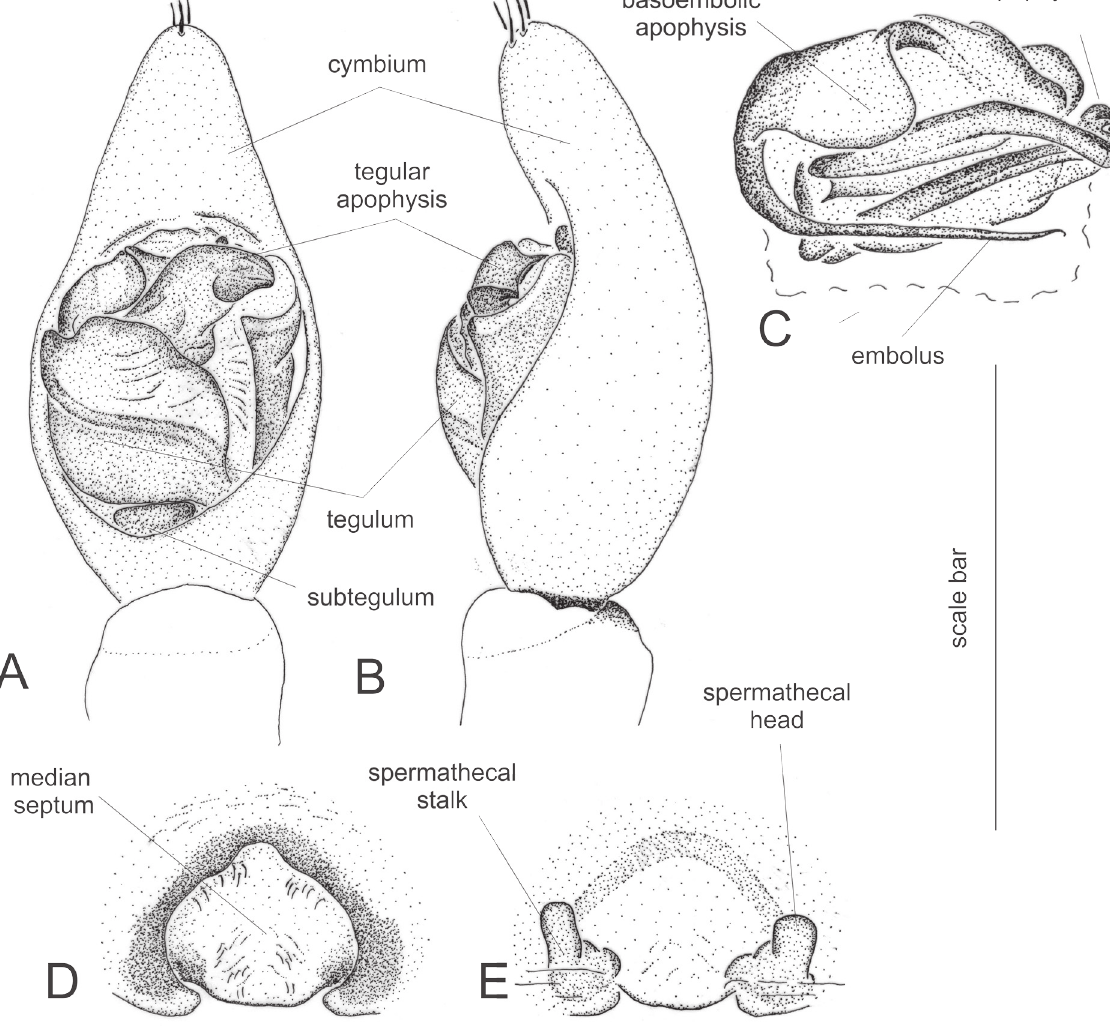
Fig. 23. Tetralycosa adarca sp. nov. A–B . Left male pedipalp, ventral and retrolateral view (holotype SAM NN21882). C . Left male pedipalp, palea section of bulbus, ventral view (SAM NN21888). D–E . Female epigyne, ventral and dorsal view (paratype SAM NN21732). Scale bar: A–B = 2.34 mm; C = 1.37 mm; D–E